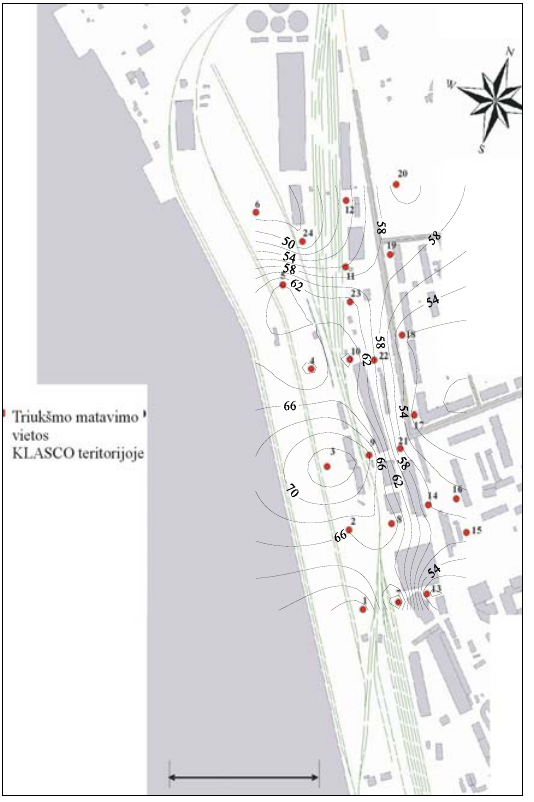
Fig 9. Dispersion of reciprocal noise level in the evening in